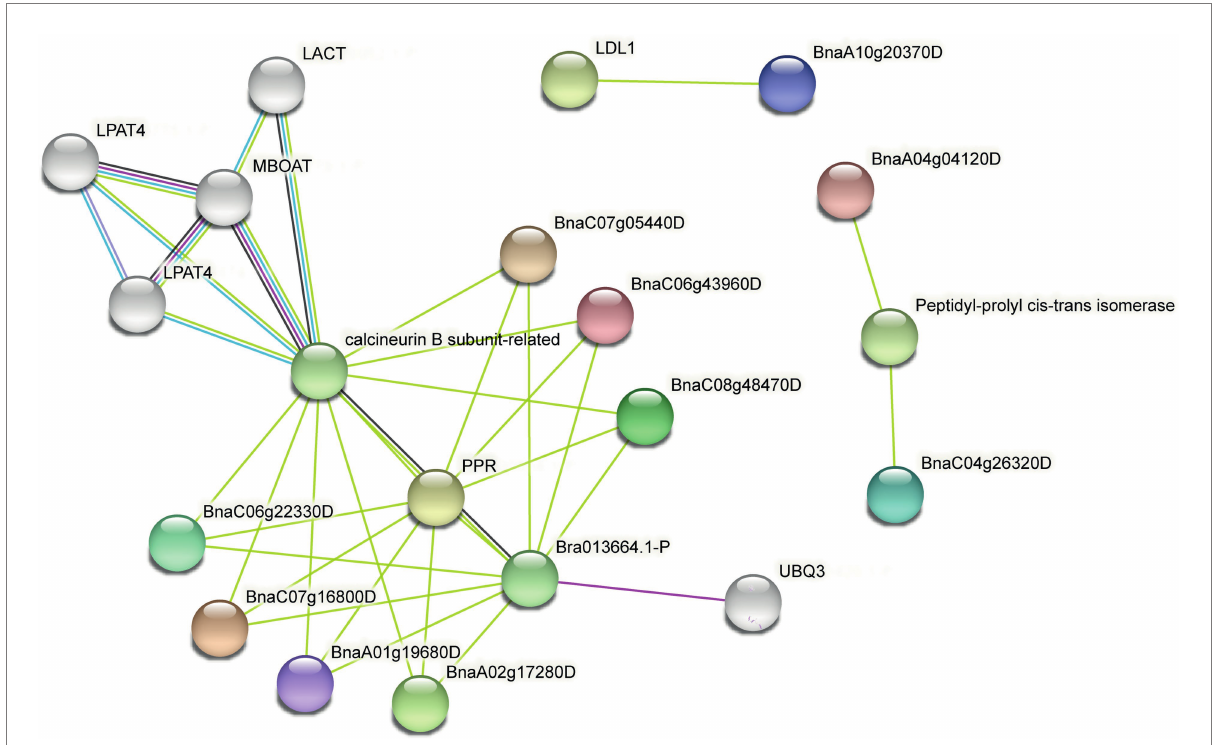
FIGURE 8 The protein–protein interaction network of SHI/STYs. Eleven SHI/STYs were involved in the construction of the protein–protein interaction network. Fifty-three protein–protein interactions were found between SHI/STYs and some other proteins. The colorful balls represent different proteins and the line between proteins indicates the interaction between the two